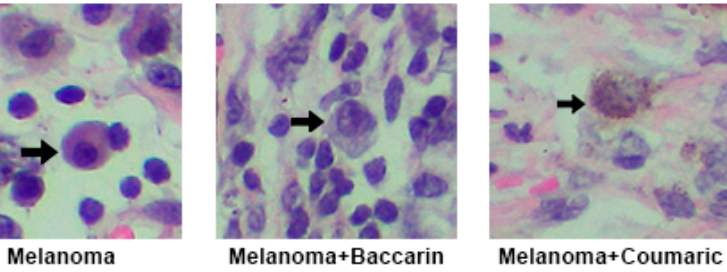
Figure 5. ( a ) Representative graphic of the tumor macrophages analysis. Baccharin increases the number of macrophages recruited to the tumor region. Comparison between the Melanoma group (B16F10 concentration of 10 6 cell/mL) that ingested only PBS and the Melanoma + baccharin group that received treatment with baccharin compound (500 µ g/kg) for 26 days. However, the p-coumaric compound did not show an effect on the recruitment of macrophages cells to the injured area. Comparison between the Melanoma group (B16F10 concentration of 10 6 cell/mL) that ingested only PBS and Melanoma + p-coumaric acid group that received the treatment with p-coumaric compound (500 µ g/kg), for 26 days. ( b ) Representative images of the macrophages’ histological section in 200 × magnification. Data represents mean ± SEM. * These differences were considered significant with p <